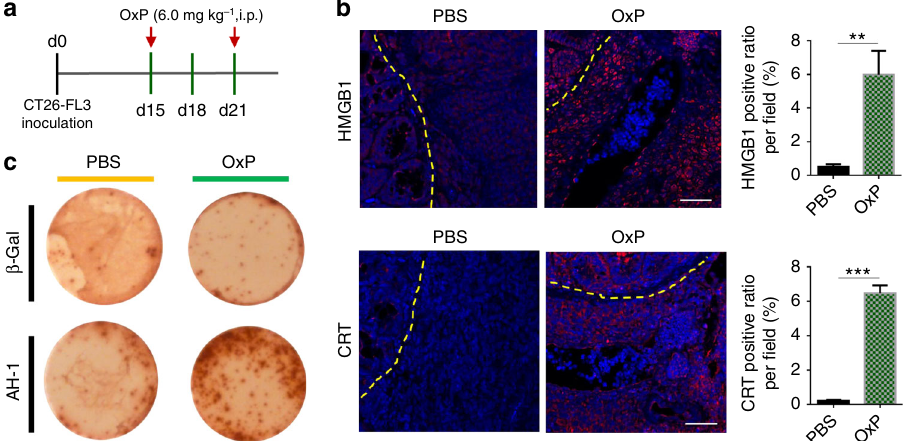
Fig. 2 OxP induces ICD in the CT26-FL3 tumor. a OxP treatment scheme. b Immuno fl uorescence staining of orthotopic CT26-FL3 tumors after PBS and OxP treatment using DAPI (blue), anti-HMGB1 antibody (red), and anti-CRT antibody (red). Positive ratios were quanti fi ed in 5 randomly selected fi elds per mouse ( n = 4 mice per group). Yellow dotted line indicates the border between intestinal mucosa and the orthotopic tumor. Scale bar represents 50 μ m. c ELISpot test of the splenocytes of CT26-FL3 tumor-bearing mice after PBS and OxP treatment. Signi fi cant differences were assessed in b using t test. Results are presented as mean (SD). ** P < 0.01, *** P < 0.001